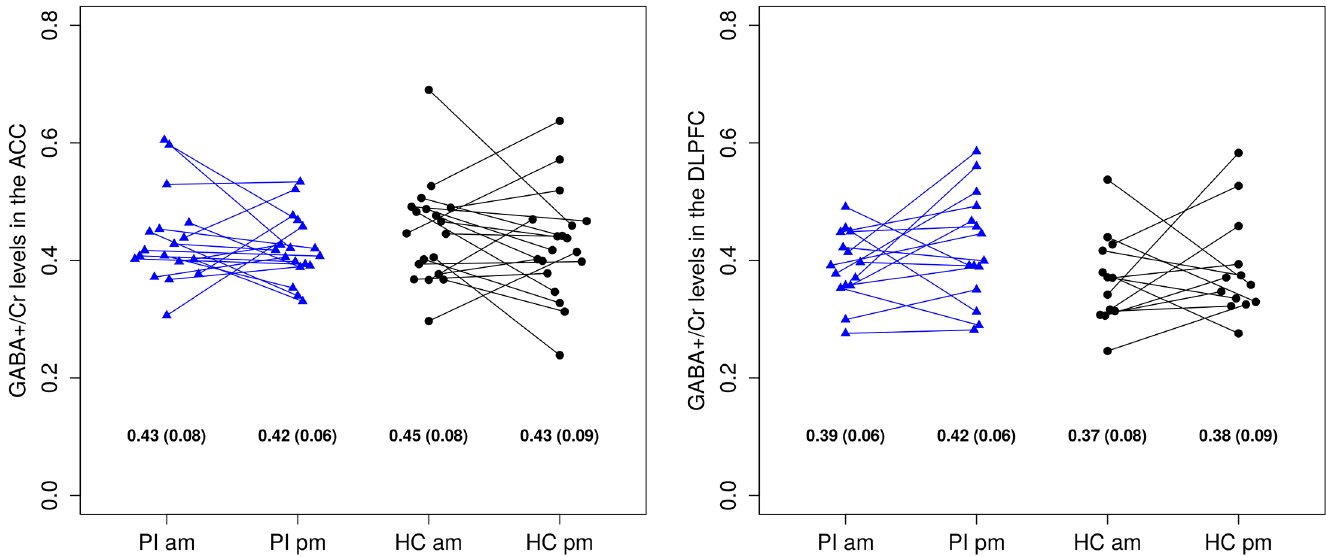
Fig 3. GABA+/Cr concentration ratios in the ACC (left) and DLPFC (right) sorted by group and measurement time. There were no significant main (GROUP; MEASUREMENT TIME) or interaction effects (GROUP x MEASUREMENT TIME). For each group and measurement time, means (standard deviations) are presented at the bottom of the figure. GABA+: free GABA, GABA moiety of homocarnosine, and macromolecular resonances of lysine and arginine at 3.0 ppm; Cr: creatine; DLPFC: dorsolateral prefrontal cortex; PI: primary insomnia; am: ante meridiem; HC: healthy controls; pm: post meridiem.